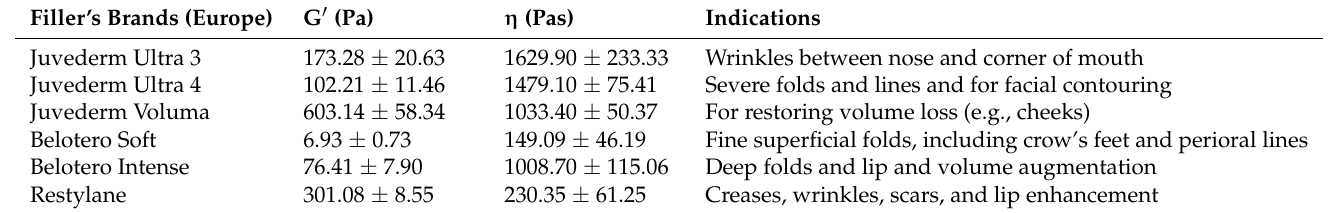
Table 3. Viscoelastic properties at 0.1 Hz (T = 37 ◦ C) and indications of representative HA soft tissue fillers (Adapted with permission from Ref. [45]. Copyright 2011, Societ à Italiana